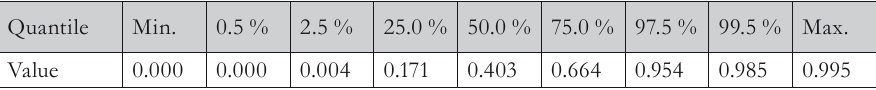
Tab. 2 – Table of the quantile values: the debt ratio. Source: Own investigation.